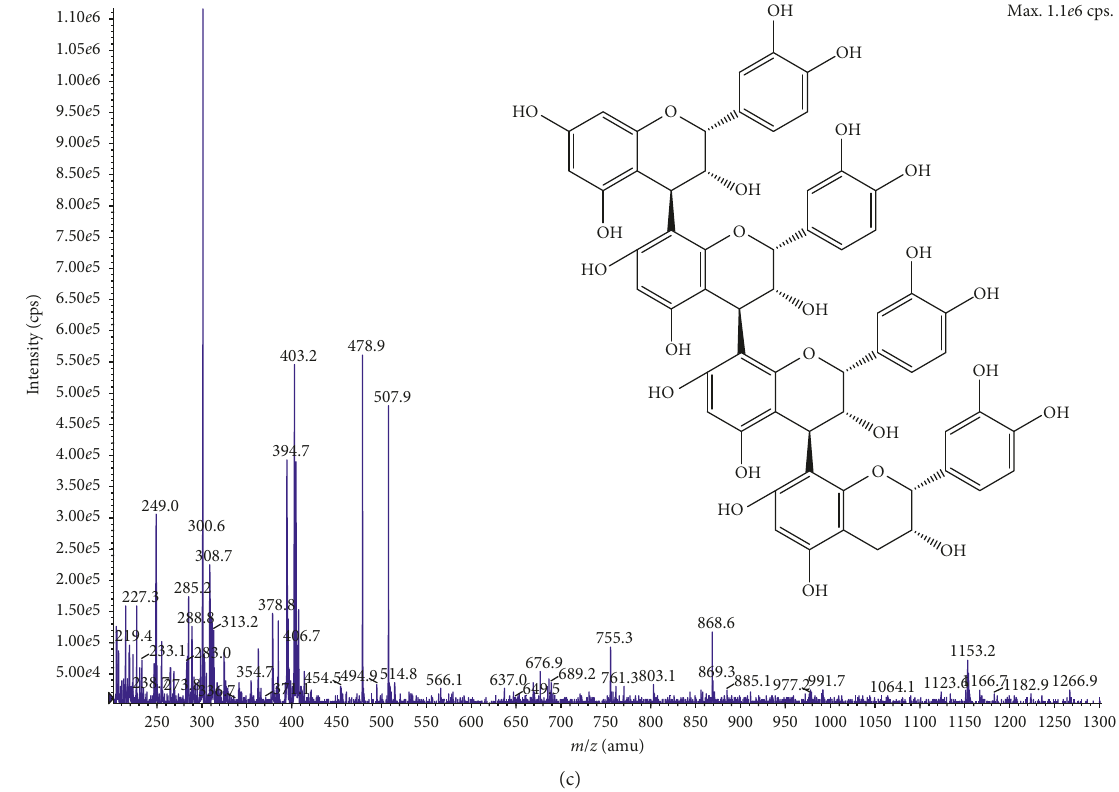
Figure 2: Fragmentation ions MS/MS in positive mode of procyanidins detected in Crataegus pubescens extracts. (a) Procyanidin dimer ( m / z 579.1); (b) procyanidin trimer ( m / z 867.2); (c) procyanidin tetramer ( m / z